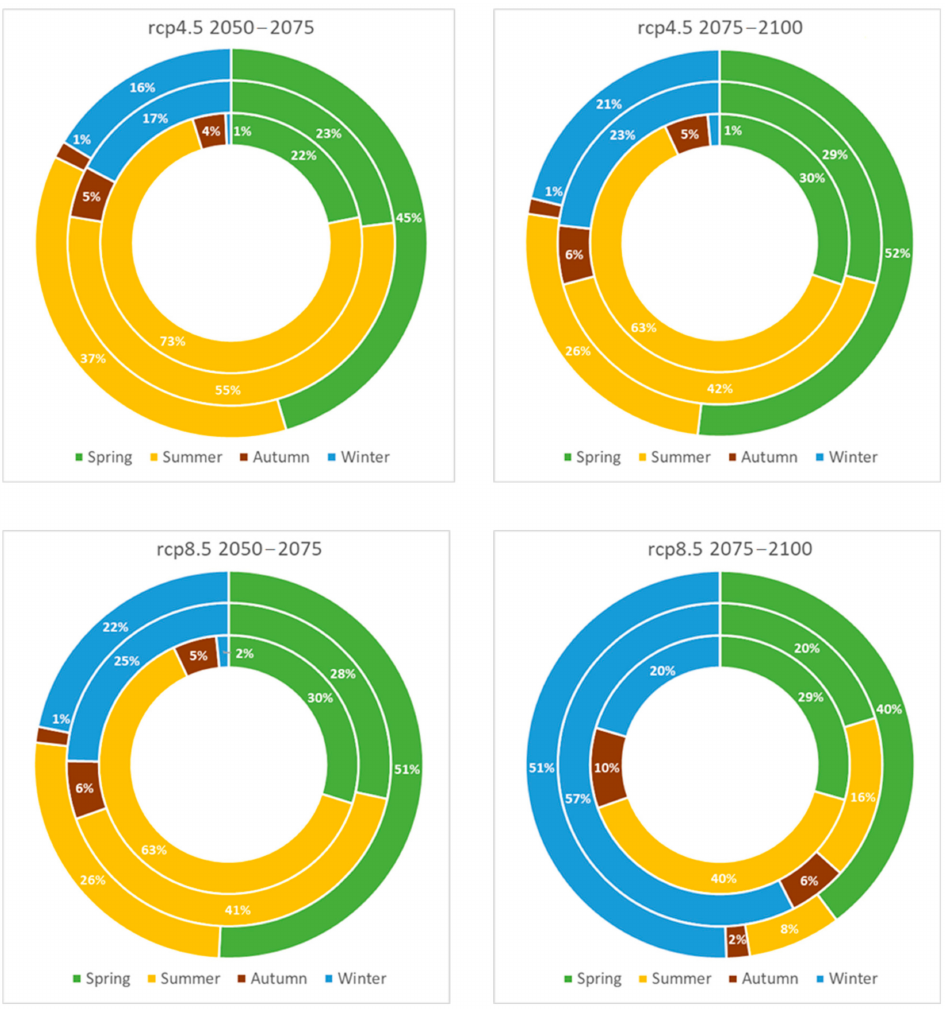
Figure 7. Example of the number of peak months over the return period 1 in 20 years per scenario- rivers within Elbe basin; catchment size: inner circle—451 km 2 , middle circle—1157 km 2 , outer circle—41,831 km 2